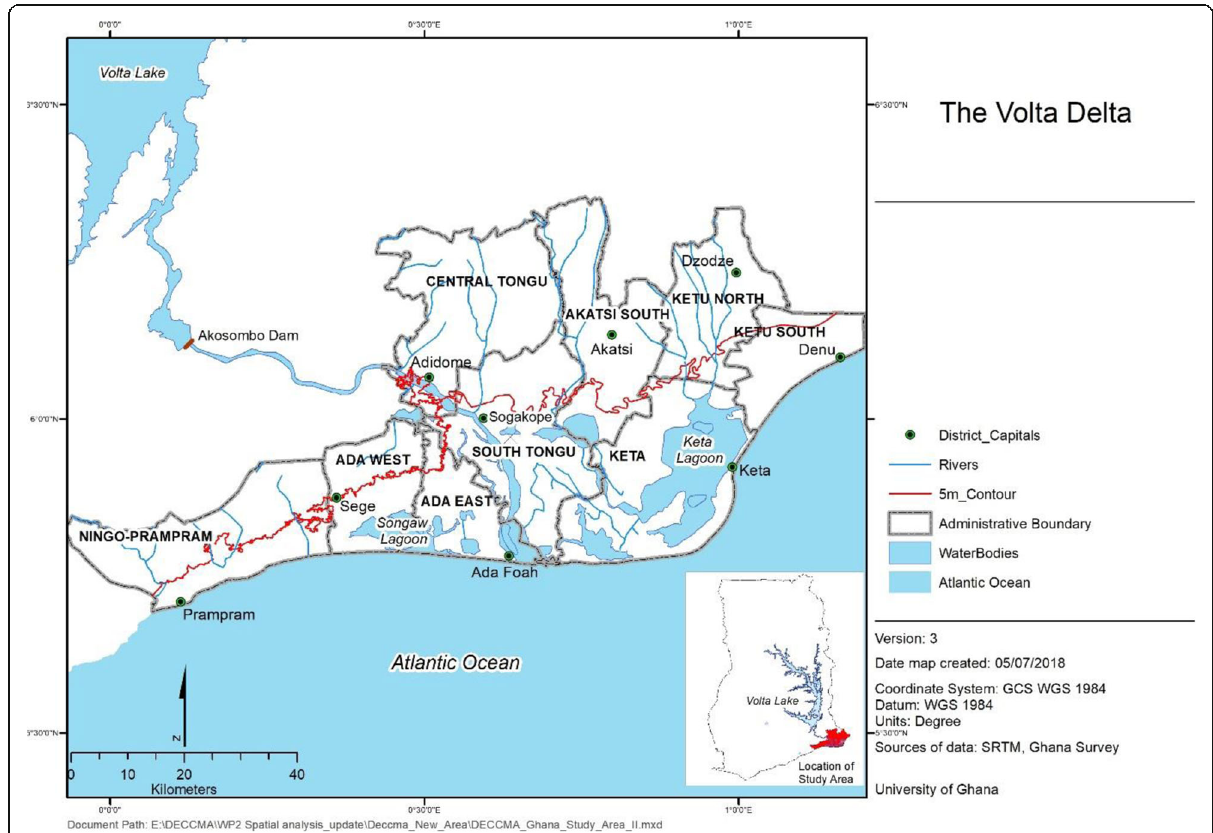
Fig. 2 Volta delta showing the 5 m contour and the administrative districts (Source: Appeaning Addo et al.